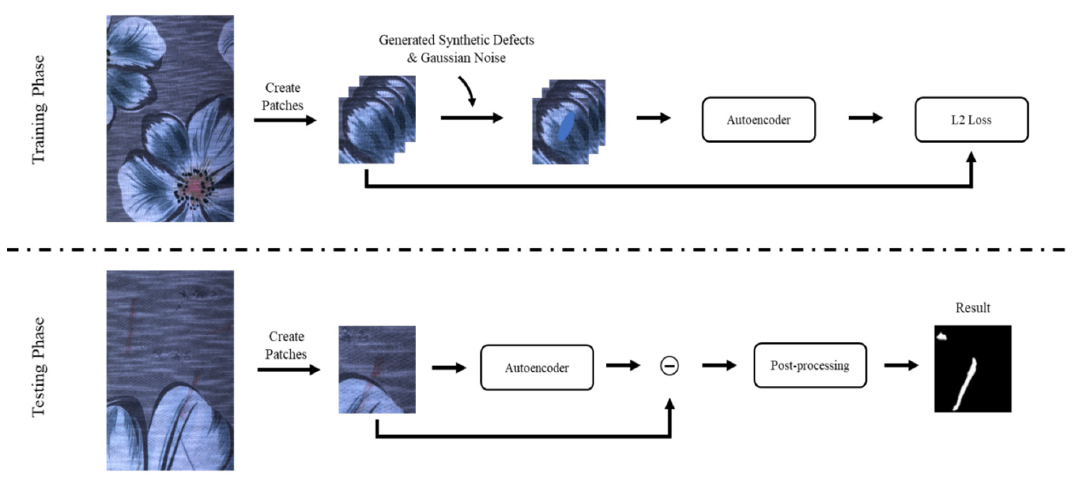
Figure 1. Overall architecture of the proposed defect detection system.